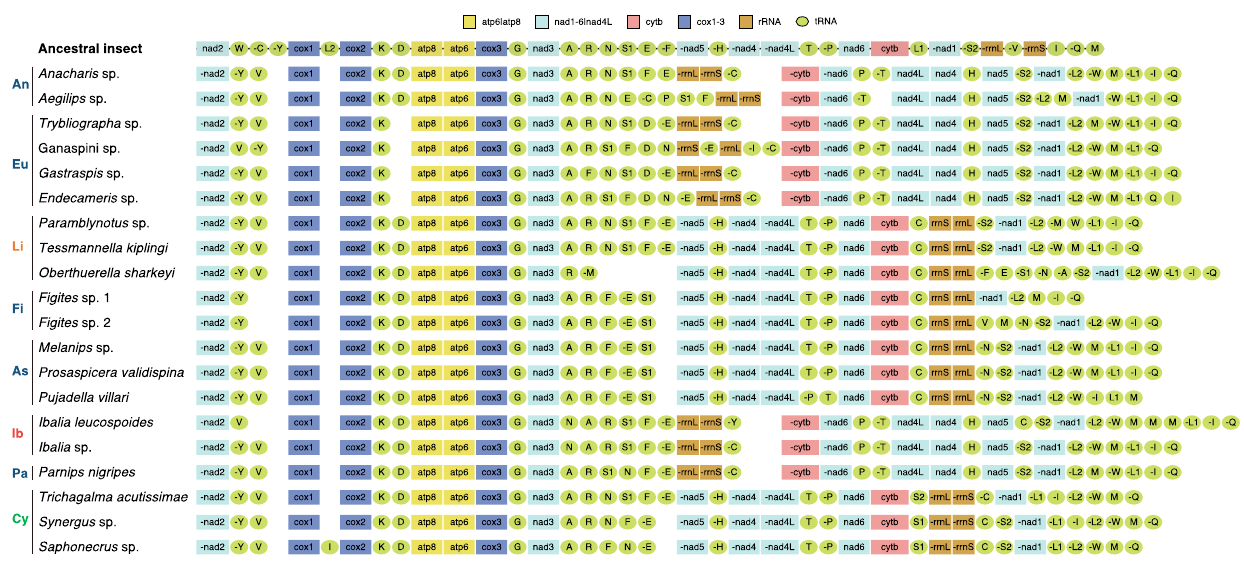
Figure 1. Mitogenomic architecture of the Cynipoidea referenced with the ancestral insect mito- chondrial genome. An, Anacharitinae; Eu, Eucoilinae; Li, Liopteridae; Fi, Figitinae; As, Aspicerinae; Ib, Ibaliidae; Pa, Parnipinae; Cy, Cynipidae. Families are shown in different colors. The A + T content for the sequenced region of the mitogenomes in the Cynipoidea ranged from 79.36% ( Trybliographa sp.) to 87.01% ( Paramblynotus sp.) (Table 2). There was no significant difference in base composition among the species of Cynipoidea. Relative high A + T content in the mitogenomes is not unusual in Hymenoptera compared with other orders [32]. Table 2. Base composition of 16 mitochondrial genomes in Chalcidoidea.